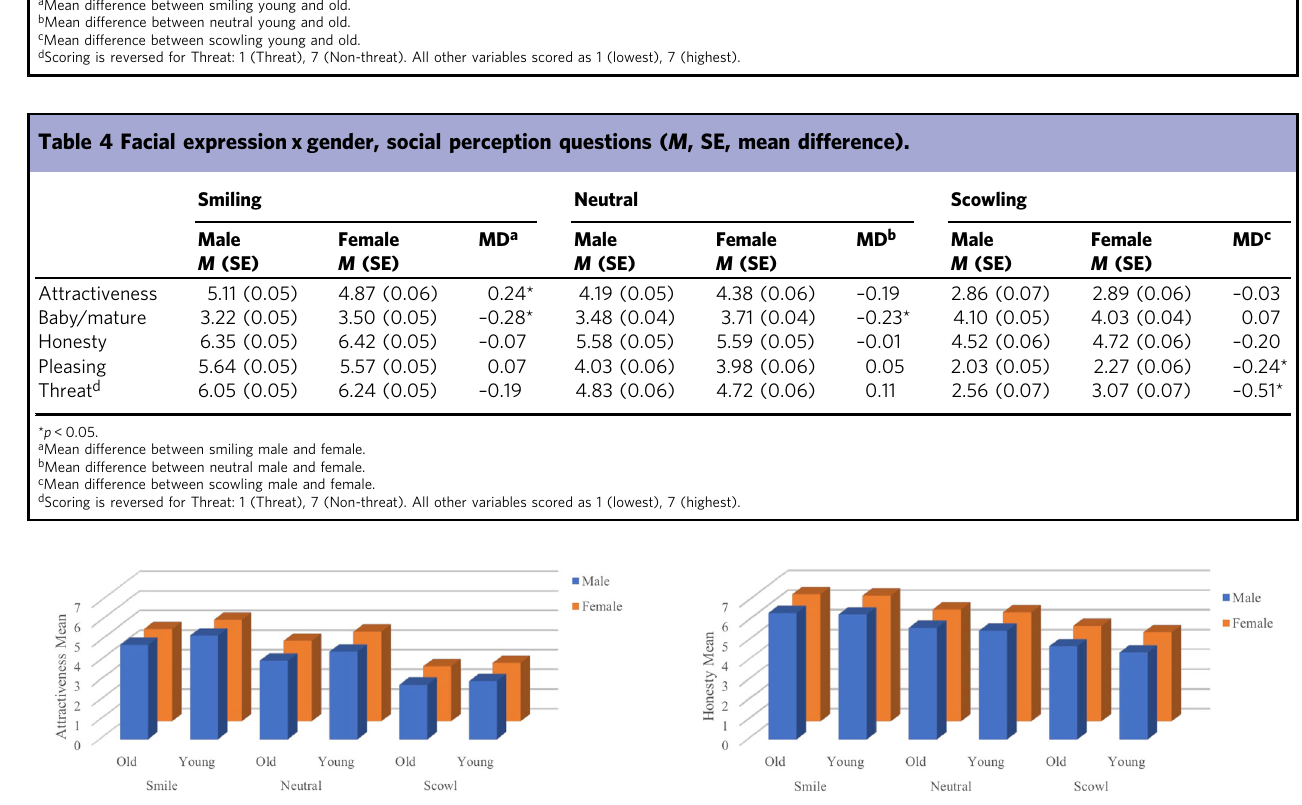
Fig. 3 Facial expression and ratings of Attractiveness. This graph presents the interaction of facial expression, age, and gender on mean ratings of Attractiveness.